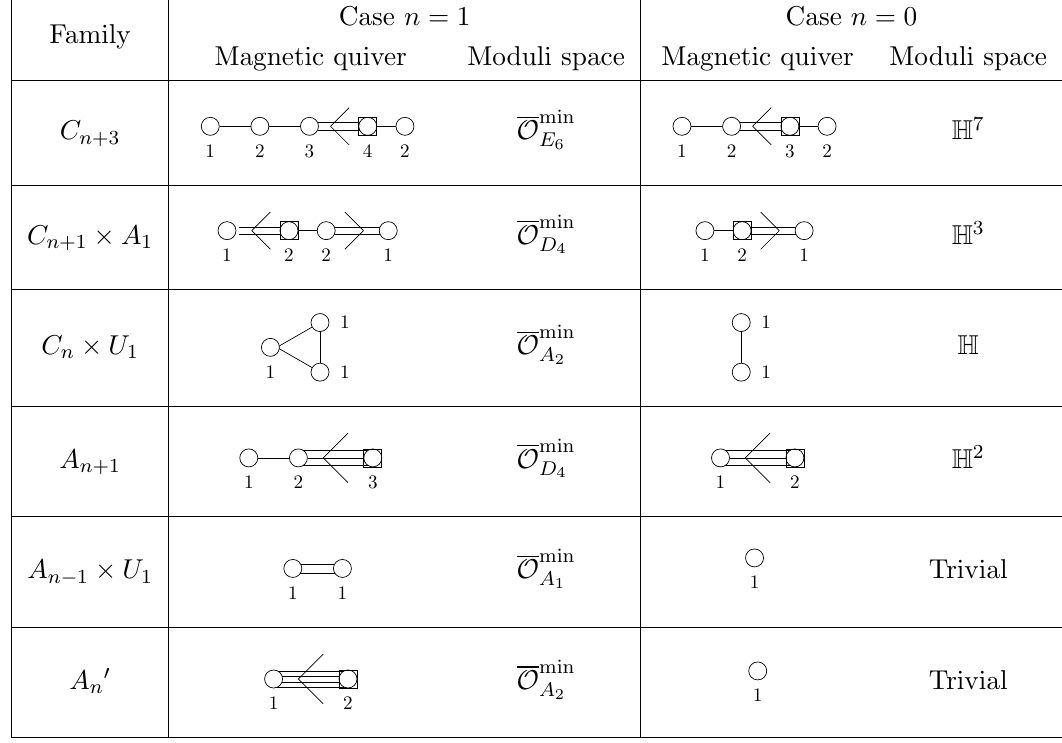
Table 12 . The n = 1 and n = 0 members of the general Families of table 11, where the Coulomb branches are closures of minimal nilpotent orbits and freely generated theories respectively. The n = 1 cases correspond to rank 1 theories without enhanced Coulomb branch. Notice that the global symmetry here does not match the labelling of the